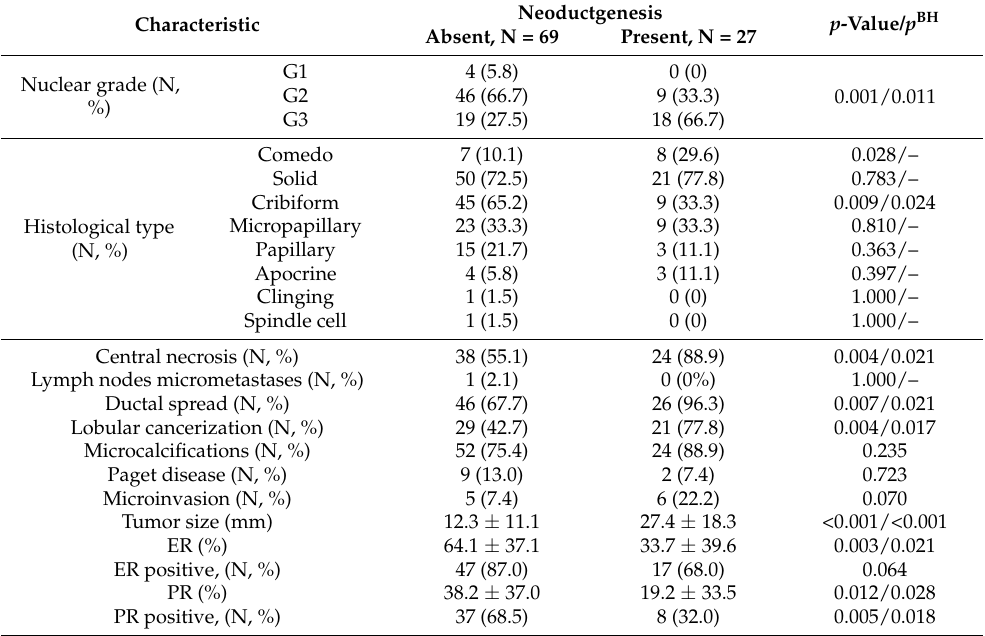
Table 2. Comparison of histological features in DCIS with or without neoductgenesis as scores 4–6.